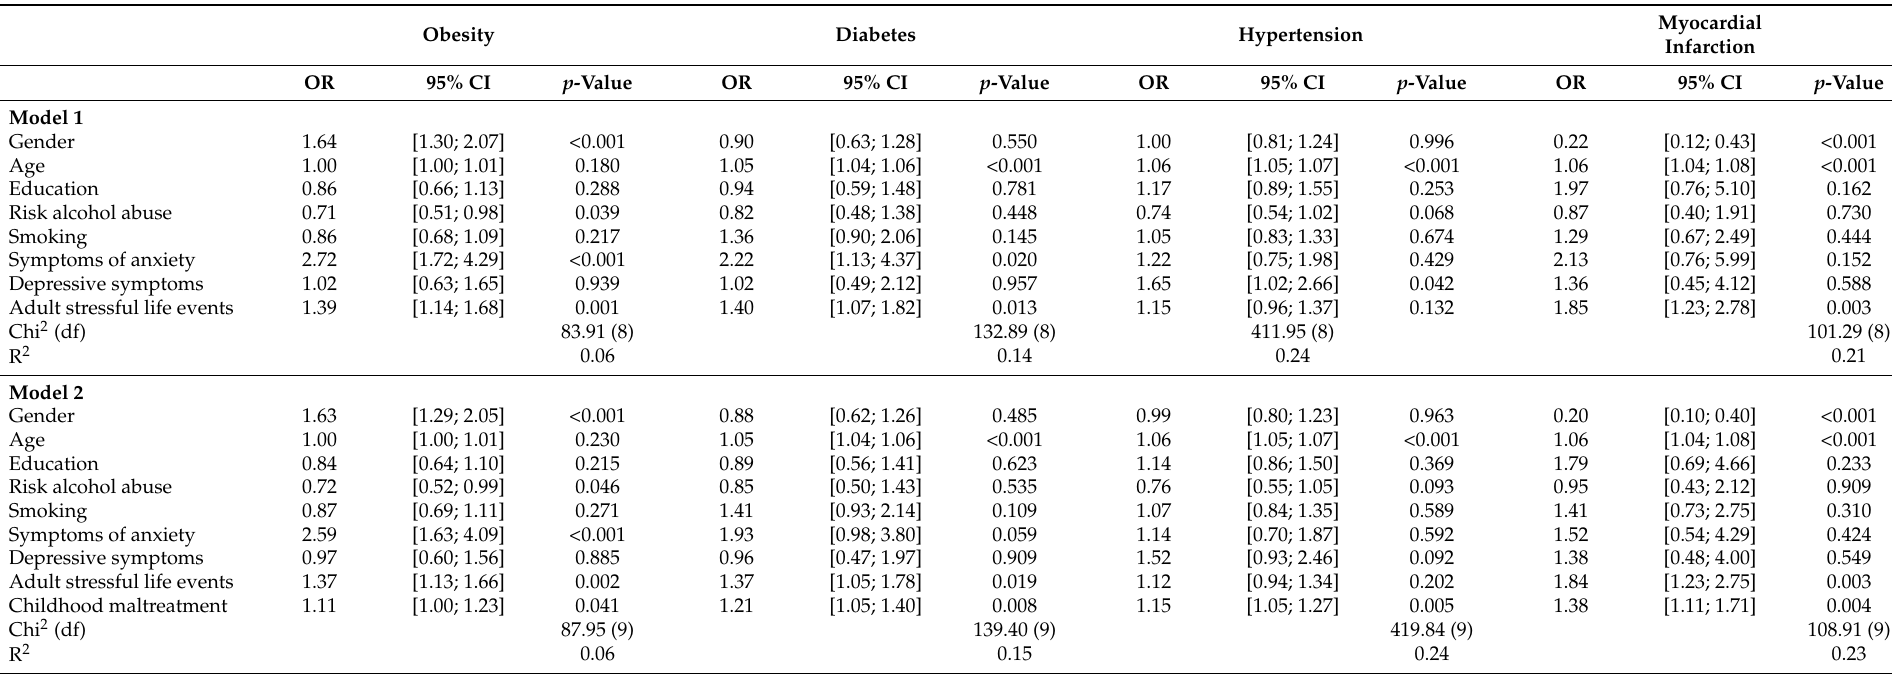
Table 3. Predictors of cardiovascular risk factors and myocardial infarction. Stratified analyzed via stepwise logistic